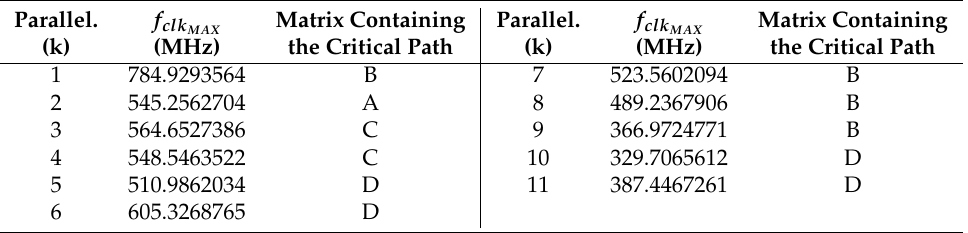
Table 2. Results of the case study synthesis on Zynq 7000 xc7z010clg400-1 field programmable gate array